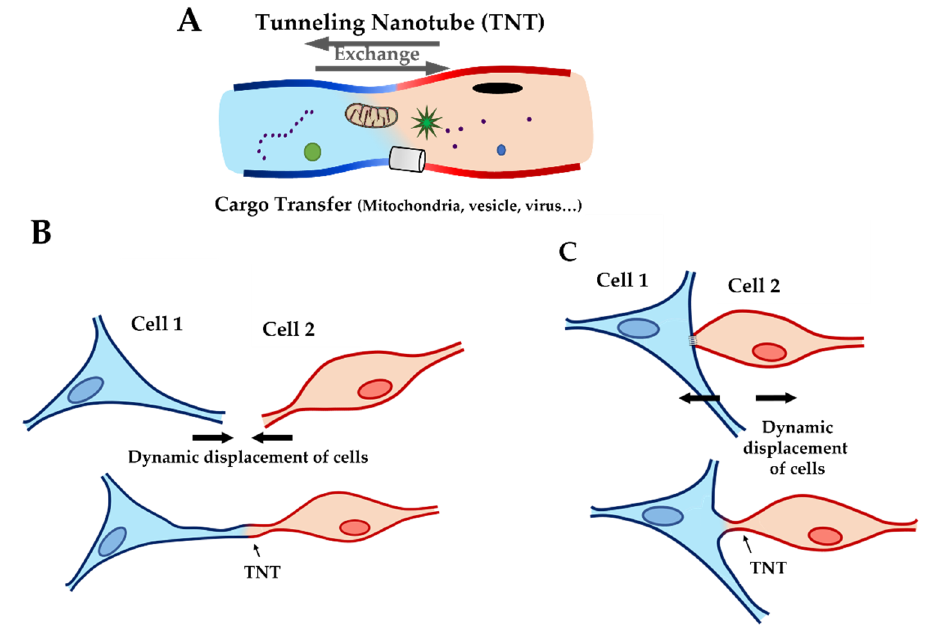
Figure 1. Cartoon showing tunneling nanotubes (TNT). ( A ) Cargo transfer through TNT with exchange of particles (such as mitochondria, ions, virus . . . ) between two cells. ( B ) TNT construction by extension of filopodia. ( C ) TNT construction by contact, formation of TNT after physical contact between two cells and distancing of cells.